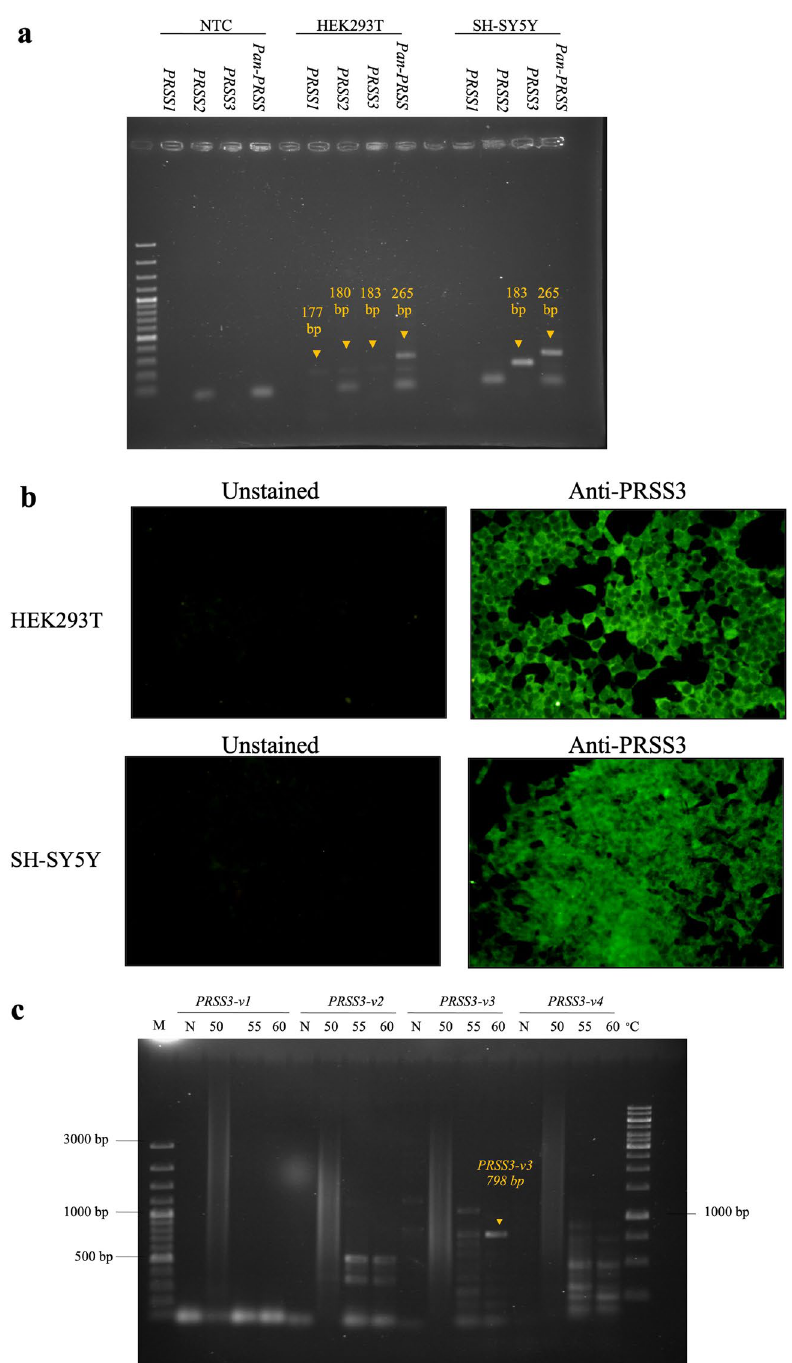
Figure 3. ( a ) Agarose gel electrophoresis of PRSS1, PRSS2, PRSS3 , and Pan-PRSS amplicons determined in HEK293T and SH-SY5Y cells by RT-PCR using specific primers. The sizes of the PCR amplicons of PRSS1 , PRSS2 , PRSS3, and Pan-PRSS are 177, 180, 183, and 265 bp, respectively. ( b ) Micrographs of fluorescent signals from HEK293T and SH-SY5Ycells stained with anti-PRSS3 polyclonal antibody to detect endogenous PRSS3 protein expression. ( c ) Agarose gel electrophoresis of amplicons of full-length PRSS3 transcript variants determined in SH-SY5Y cells by RT-PCR with gradient annealing temperatures. Individual full-length transcript variant of PRSS3 were amplified by RT-PCR using annealing temperatures at 50, 55, and 60 °C. Only PRSS3 transcript variant 3 ( PRSS3-V3 ) at the size of 798 bp could be amplified using annealing temperature at 60 °C as indicated by the arrows. Lane M, 100 bp Plus DNA ladder (in base pairs, bp). Lane NTC or N, non-template